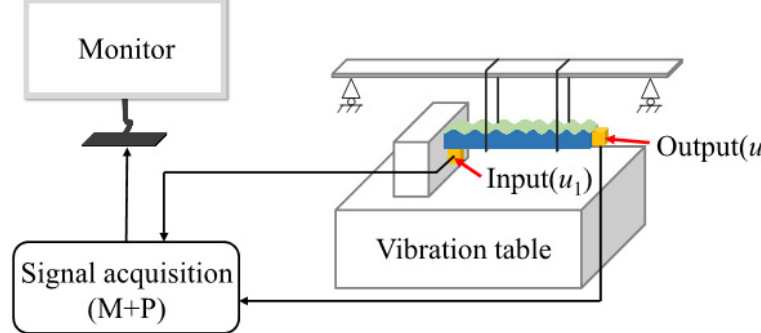
Figure 9. Wrinkled sample with composite patterns: ( a ) the thickness ratio H f / H s of 7.0 × 10 − 2 and